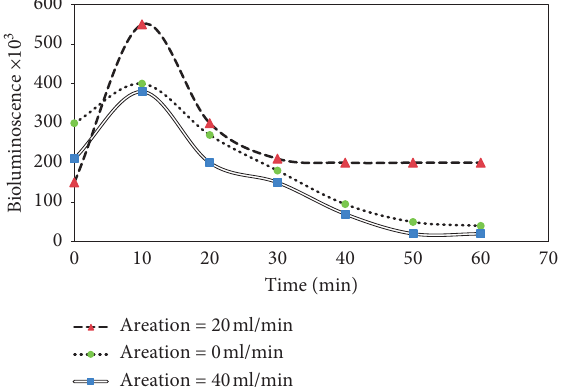
Figure 9: Effect of the aeration rate on the BL of the immobilized cells ( T � 37 ° C).